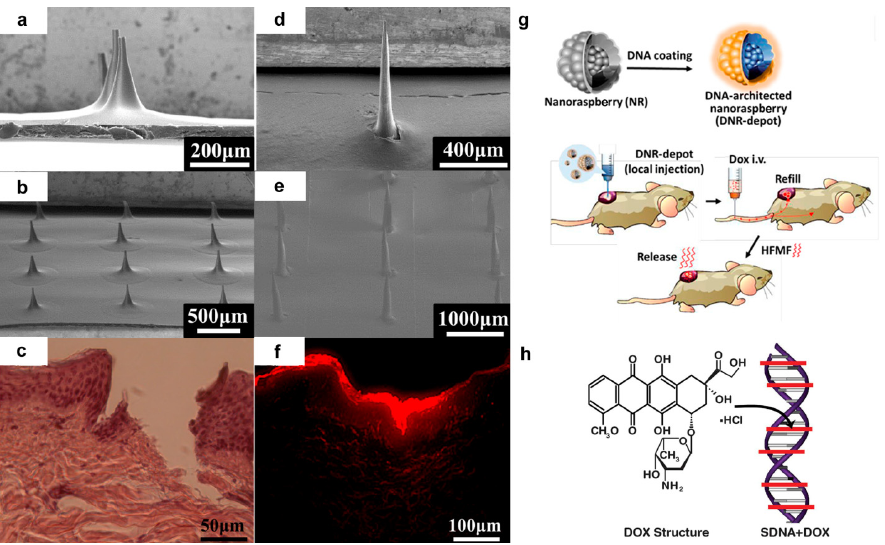
Figure 1. Scanning electron microscopy images of a single 300 µm-DNA microneedle ( a ), an array of 300 µm-DNA microneedles ( b ), a single 1000 µm-DNA microneedle ( c ), an array of 1000 µm-DNA microneedles ( d ), cross-section of a pork skin with a DNA microneedle-insertion site ( e ), model drug (rhodamine) distribution from the DNA-microneedle ( f ). Reproduced from [29] under Creative Commons CC BY license (http://creativecommons.org/licenses/by/4.0/, accessed on 25 November 2021). Copyright 2017 the authors; scheme of formation of DNA coated iron nanoparticles (nanorasberry) and their action as magnetoresponsive DOX depots ( g ). Reproduced with permission from [31]. Copyright 2020 Royal Society of Chemistry; schematic representation of DOX structure and its interaction with salmon DNA ( h ). Reproduced from [33] under Creative Commons CC BY license (http://creativecommons.org/licenses/by/4.0/, accessed on 25 November 2021). Copyright 2015 the authors.